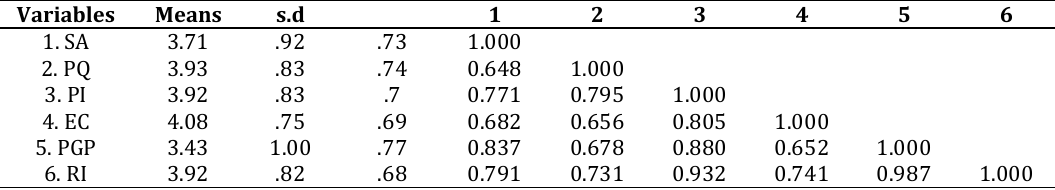
Table 1: Means, standard deviations , Cronbach’s alphas and correlations